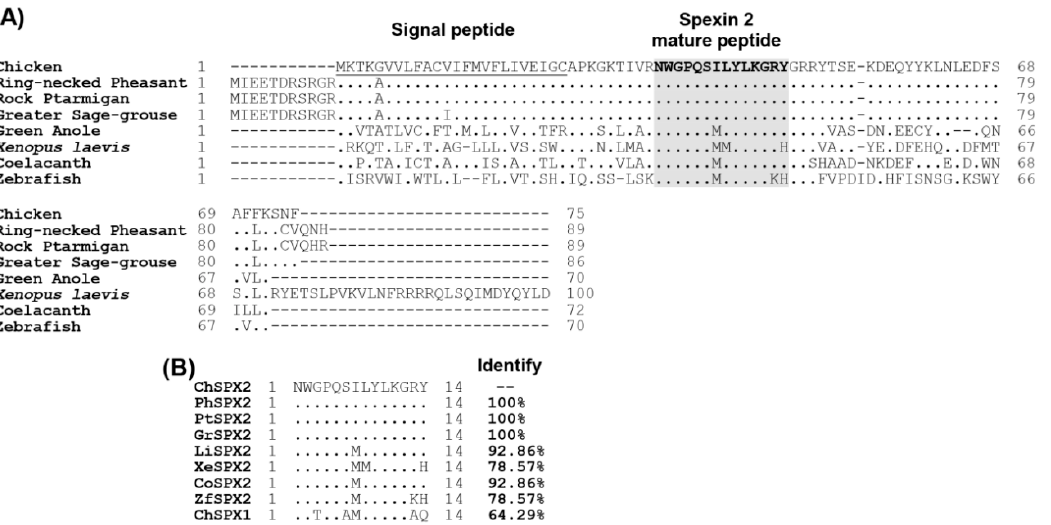
Figure 1. Cloning and sequence analysis of chicken (c-) SPX2 . ( A ) The full-length cDNA sequence and deduced amino acid of chicken Spexin2 ( cSPX2 ). The predicted signal peptide (24 amino acids) is underlined, and the mature peptide (14 amino acids) is shaded in gray, which is flanked by two dibasic cleavage sites noted by italic letters. ( B ) Exon (E)-intron organization of cSPX2 , the numbers indicate the sizes of exons or introns, and arrowheads represent the locations of start codon and stop codon.